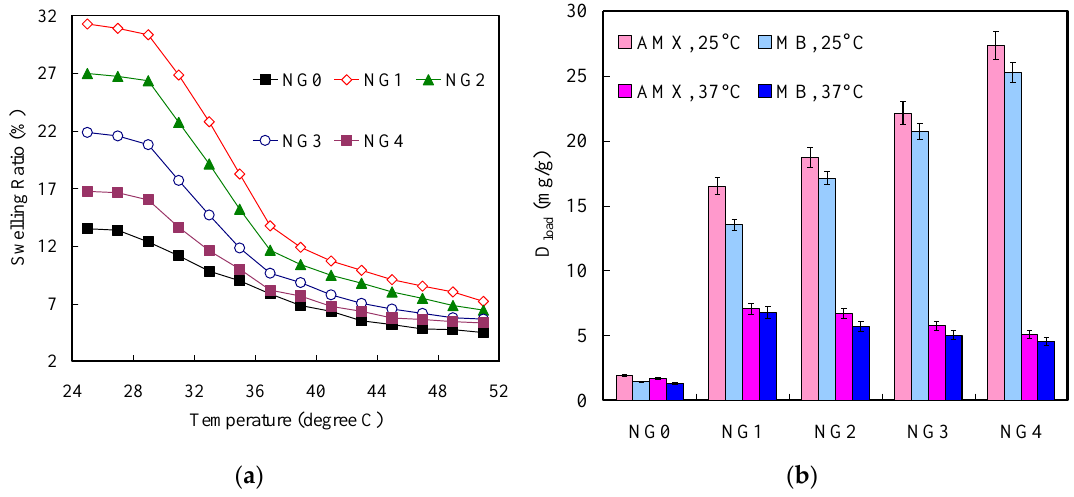
Figure 7. ( a ) Swelling ratios of NG0, NG1, NG2, NG3, and NG4 plotted with respect to temperature from 25 to 51 °C. ( b ) D load of of NG0, NG1, NG2, NG3, and NG4 for amoxicillin (AMX) and methylene blue (MB) at 25 and 37 °C, respectively.